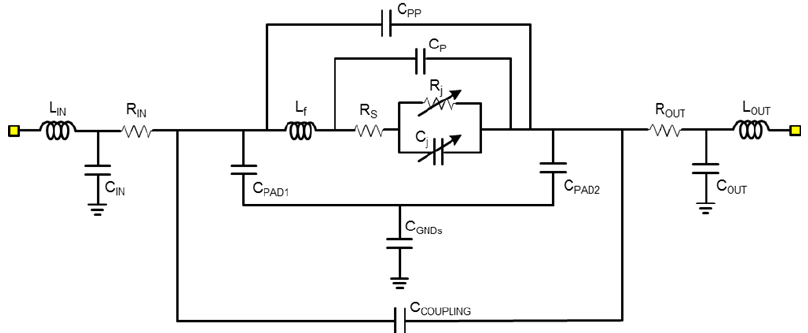
Figure 12. Equivalent circuit model for the ZBD in flip-chip assembly.